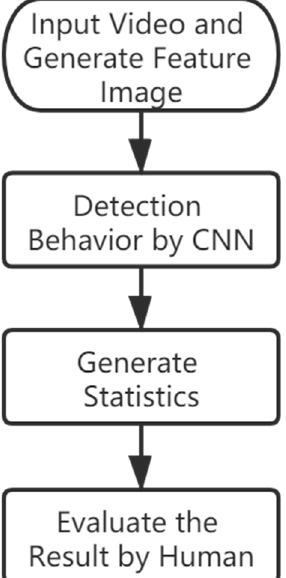
Figure 12. Recording process of the grooming behavior in this paper.